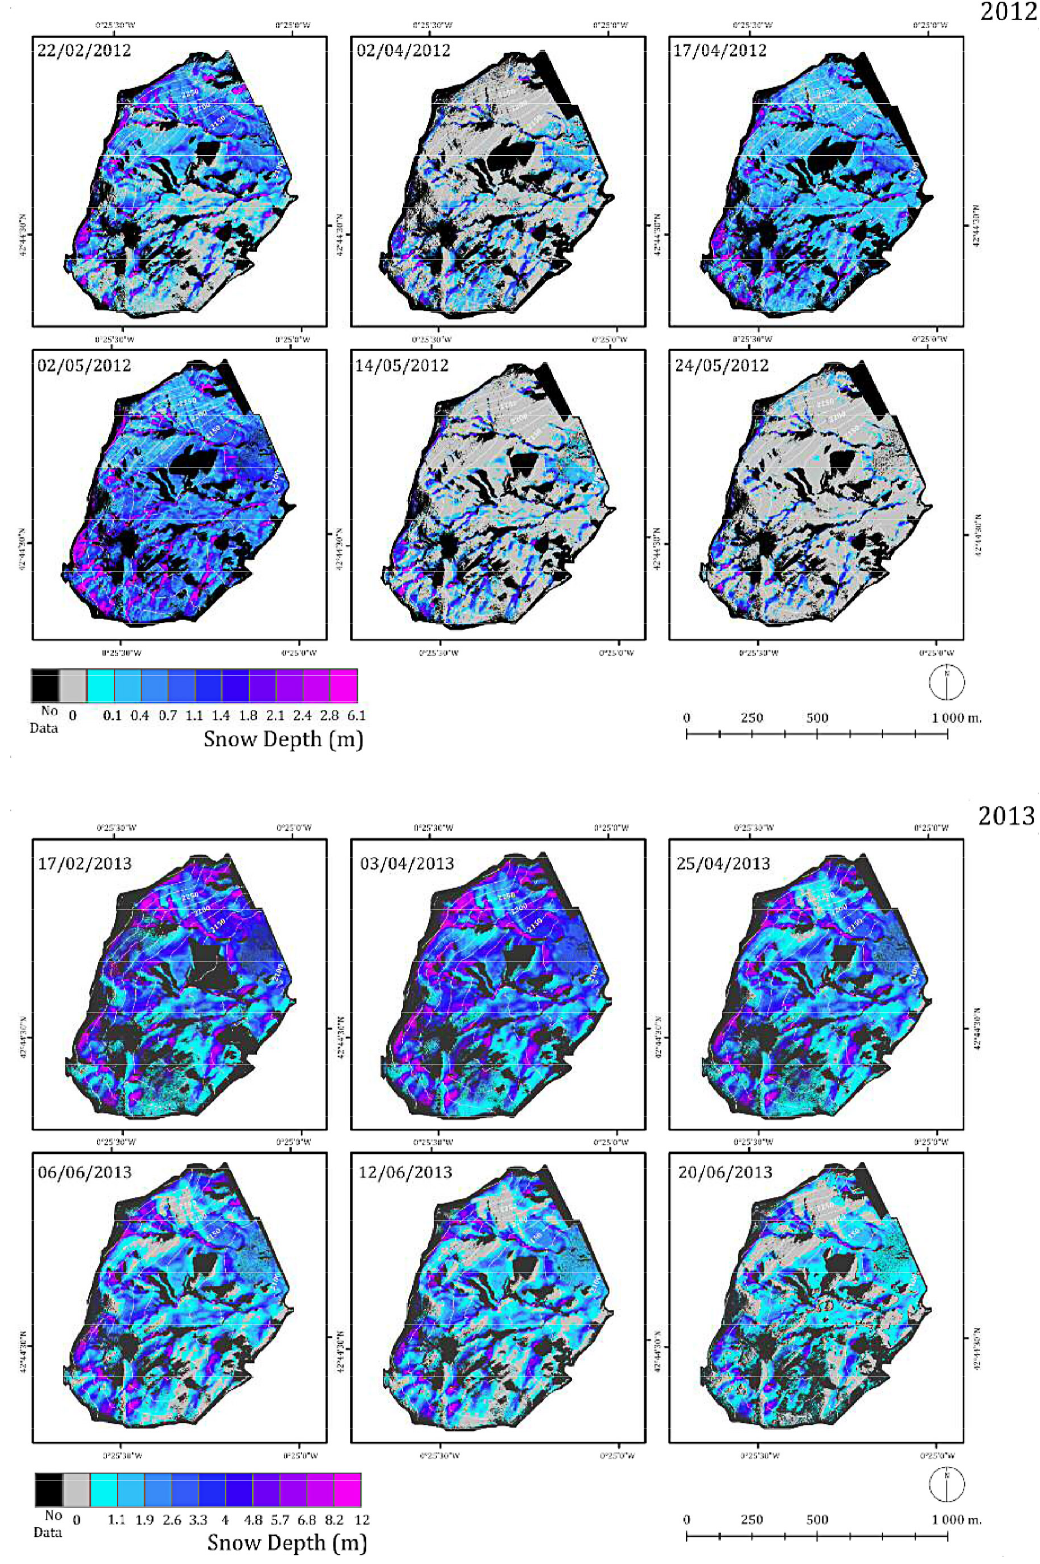
Figure 3. Spatial distribution of snow depth in the Izas experimental catchment in the surveys undertaken in 2012 and 2013.